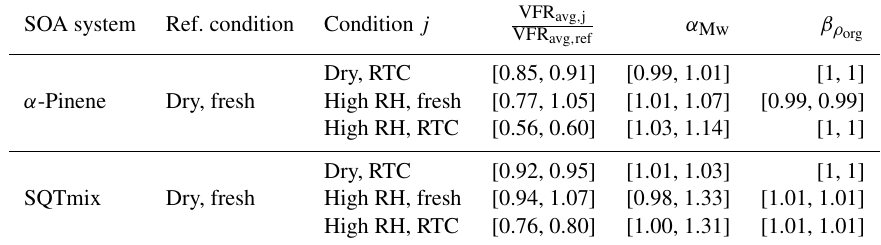
Table C2. Ranges of parameters for calculating the net change ratio (NCR) for each PMF sample factor. SOA system Ref.